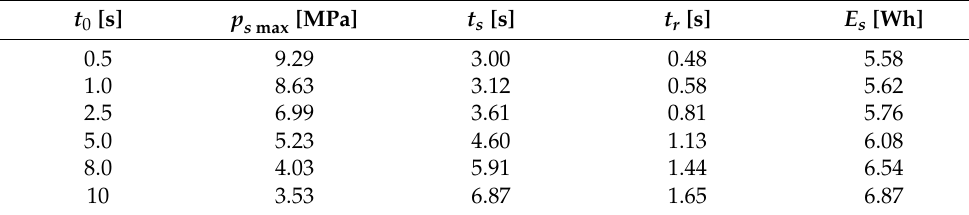
Table 1. Comparison of the control signal parameters and dynamic surplus pressure values at the inlet port of the motor, and the transmission start-up duration and reaction time. Transmission controlled with the serial throttle method without